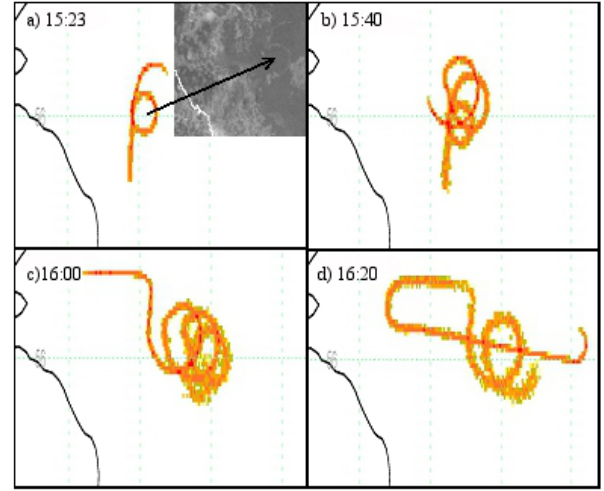
Fig. 2. The dispersion of the plume as predicted by the NAME model. (a) 15:20, (b) 15:40, (c) 16:00, (d) 16:20. The contrail is assumed to have a lifetime of 45min and is removed from the anal- ysis after this time to aid clarity. A satellite image (10.8 to 12.0µm product from NOAA 15, overpass at 15:23UTC) is shown as part of (a) , this shows contrail orbit 1, merging with contrail orbit